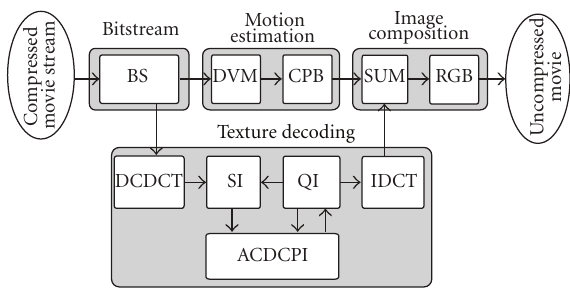
Figure 6: MPEG-4 decoder schematic.